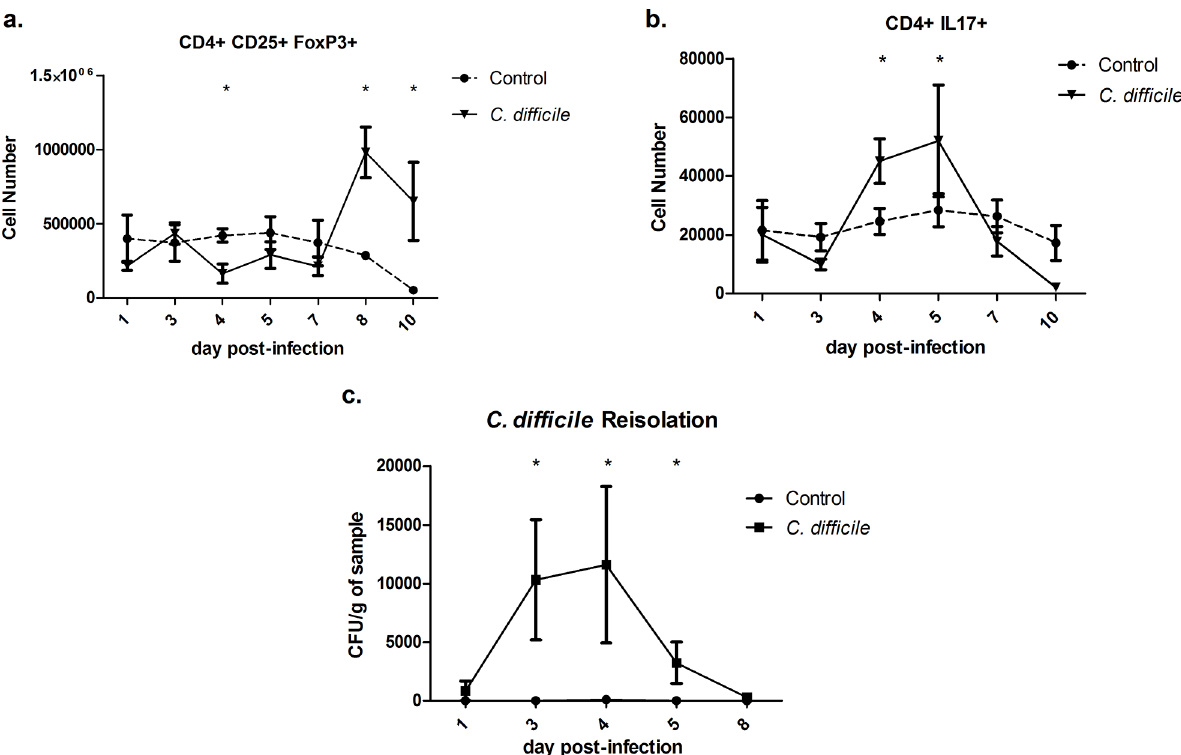
Fig 2. Time course of Clostridium difficile infection in mice. (a and b) Flow cytometry analysis of colonic lamina propria lymphocytes from days 1 to 10 post-infection showing the differences in CD4+ CD25+ FoxP3+ regulatory T (Treg) and CD4+ IL17+ T helper 17 (Th17) cells, respectively, between control and C . difficile challenged wild type mice. (c) Re-isolation data of C . difficile from colonic contents from day 1 to day 8 post-infection. Data points and error bars represent mean ± standard error of the mean (SEM). Asterisks ( * ) mark significance ( P (cid:1) 0.05) in comparison between control and C . difficile infected mice (n = 10).